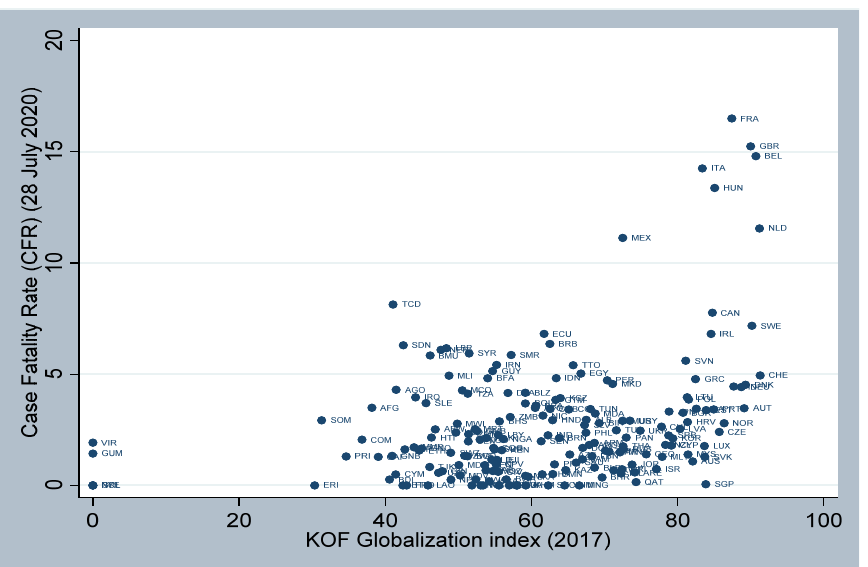
Figure 1. Association between case fatality rate (CFR) and the KOF Globalization Index. Source: The KOF Globalization Index from the latest available year (2017) (from 0 to 100- higher value indicates higher level of globalization) is from Gygli et al. (2019). CFR cumulated by 28 July 2020 is from European Centre for Disease Prevention and Control (ECDC 2020).